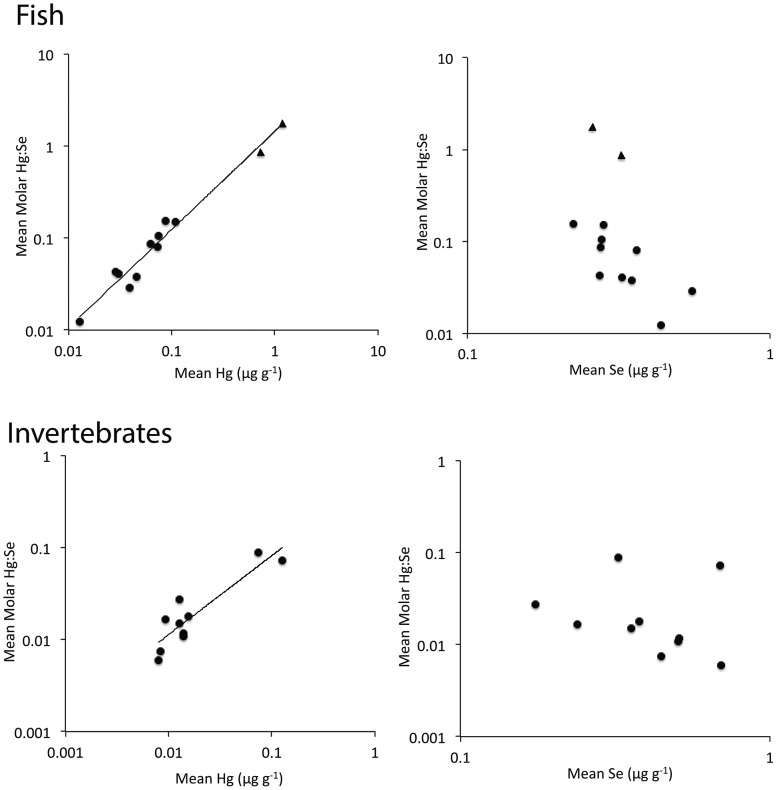
Relationships between Hg (left), Se (right) and Hg:Se molar ratios in fish (top) and invertebrates (bottom).Hg content is more strongly related to Hg:Se molar ratios than Se content. The range of the axes varies among panels. Shark taxa are shown as triangles. Hg and Hg:Se relationships are described by the equation for fish: Log10(Hg:Se)  = 0.17+1.0*Log10(Hg), R2 = 0.98, P<0.0001, F1,10 = 410 and invertebrates Log10(Hg:Se)  = −0.22+0.87*Log10(Hg), R2 = 0.78, P = 0.0006, F1,8 = 29.